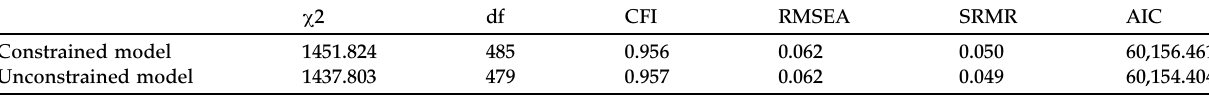
Table 4. The results of model